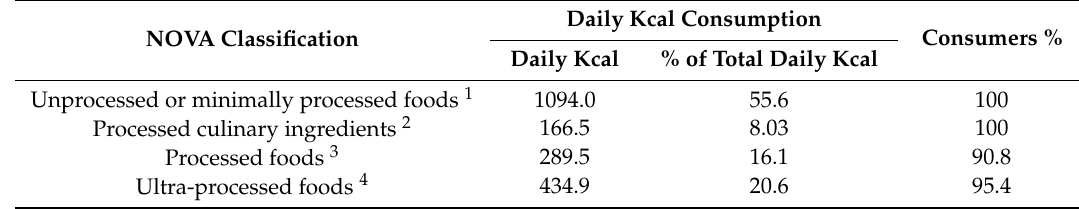
Table 4. Daily food consumption from NOVA four food classes among manufacturing workers of Rio Grande do Norte, Brazil 2017–18.